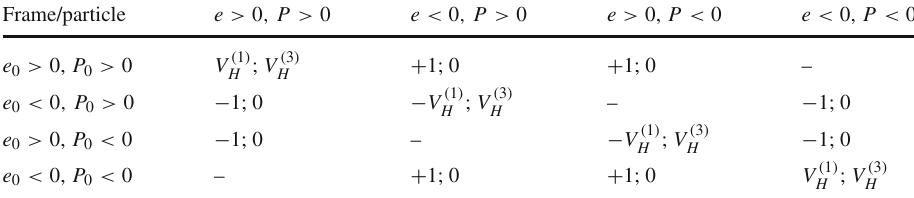
Table 2 Radial and angular velocity at a horizon of a particle with respect to a frame depending on signs of